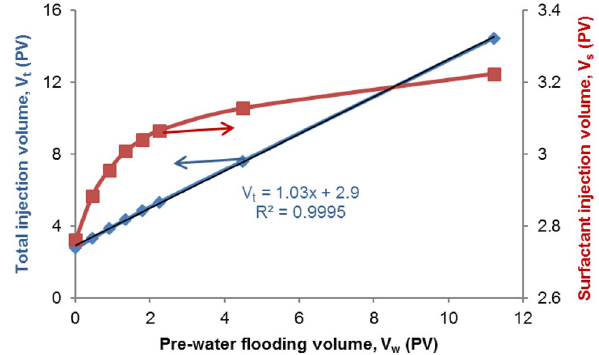
Fig. 20 The total injection volume of brine and surfactant solution and the injection volume of surfactant solution to obtain 90% of ulti- mate oil recovery (i.e., 0.72 OOIP) in the base case for flooding sce- narios with different pre-water